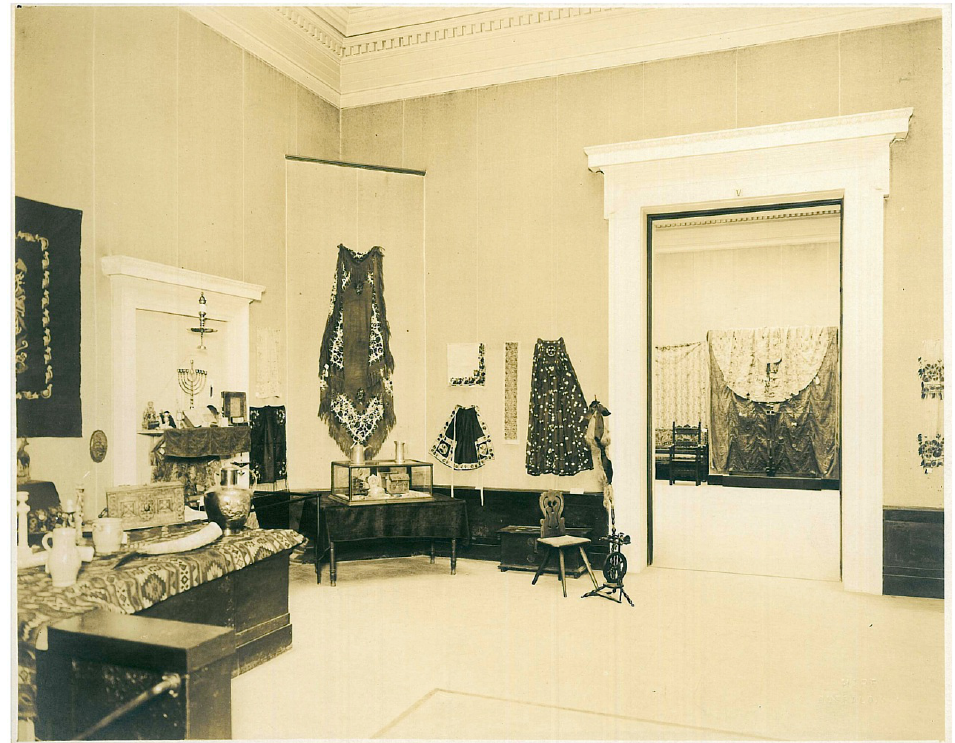
George Hare, Installation photograph of the Arts and Crafts of the Homelands exhibition held at the Albright-Knox Gallery October 22-November 4, 1919. © 2013 Albright Knox Gallery. Image courtesy of the G. Robert Strauss, Jr. Memorial Library, Gallery Archives, Albright Knox Gallery, Buffalo, New